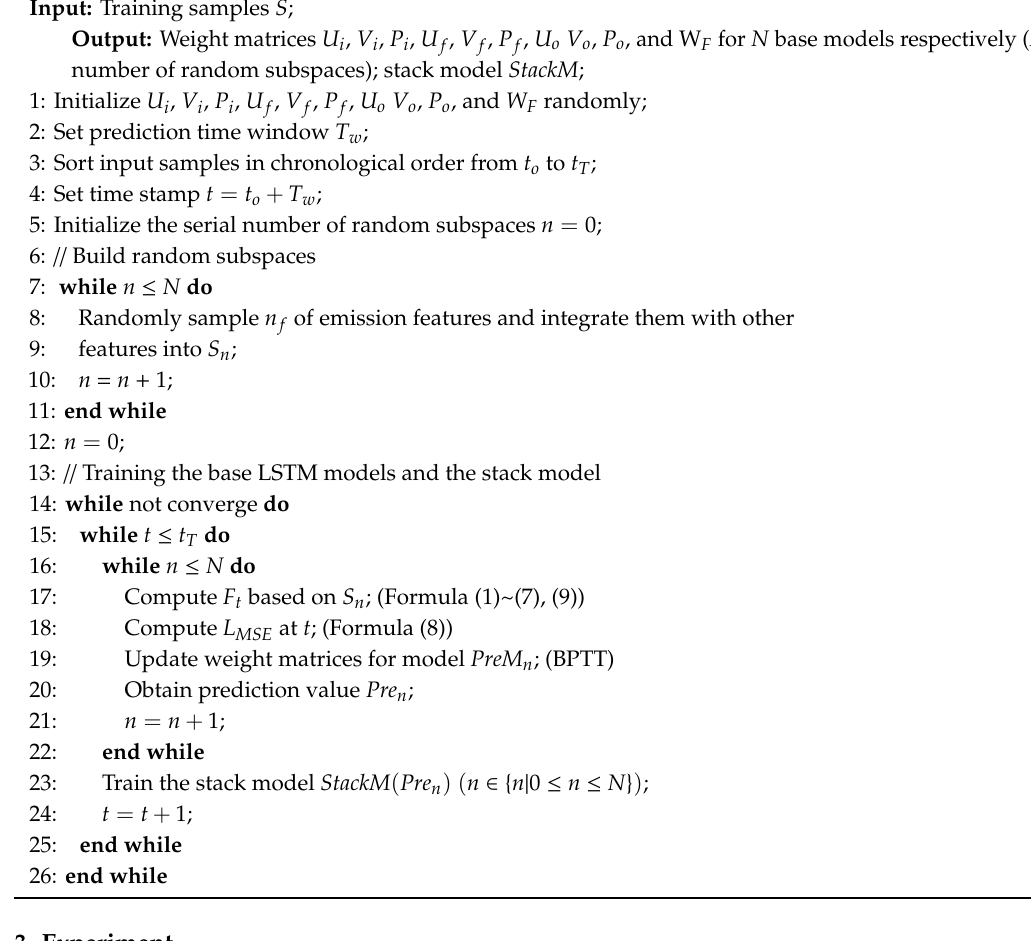
Algorithm 1: Learning LSTM-DRSL through